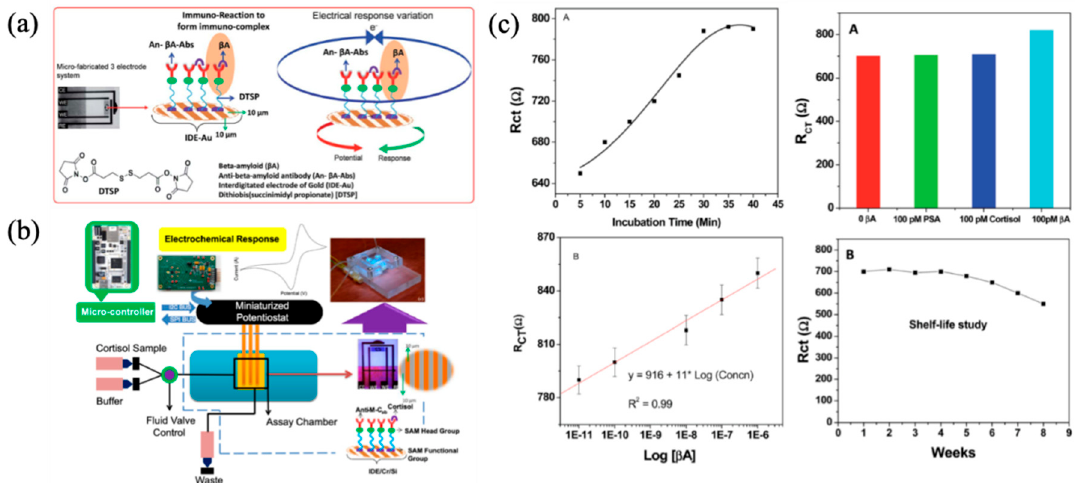
Figure 7. ( a ) Principle of interdigitated electrode of the gold (IDE-Au) immunosensor; ( b ) the system with IDE-Au based immunosensor and ( c ) measured results of A β using this system and the stability of the IDE-Au based immunosensor. Reproduced from reference [85] with permission from The Royal Society of Chemistry.